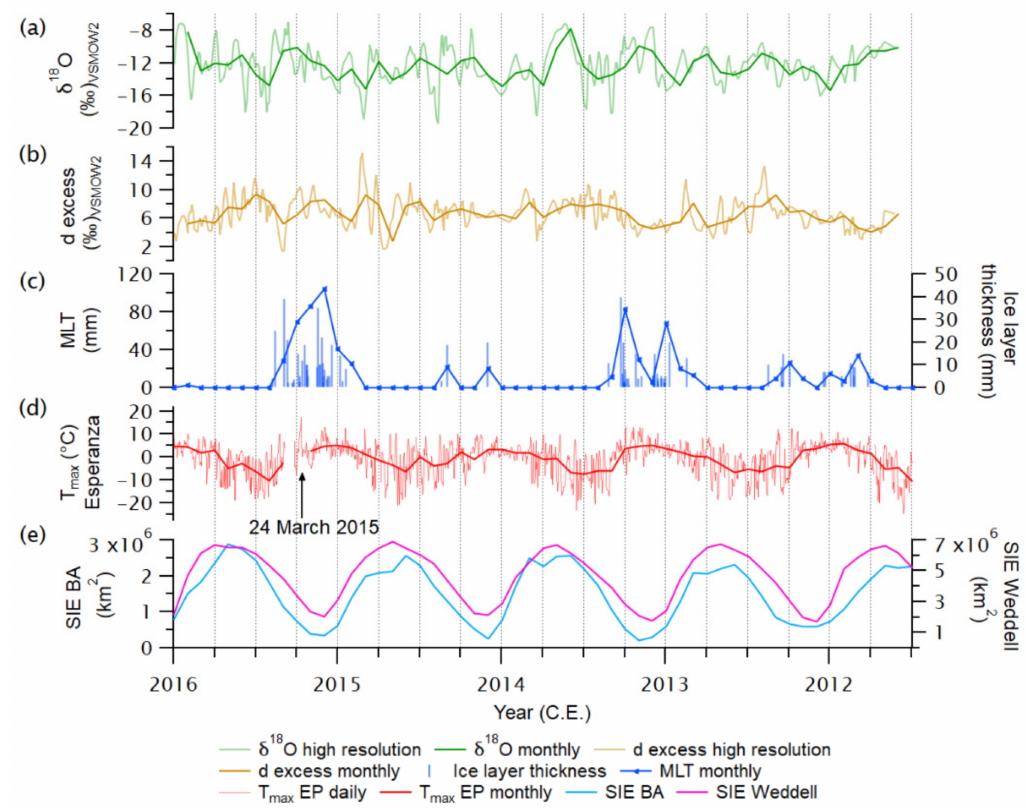
Figure 8. High-resolution (light-coloured lines) and monthly (bold lines) records of OH-12 ( a ) stable oxygen isotopes (green), ( b ) d excess (brown) and ( c ) total melt layer thickness (MLT) calculated from ice layers indicating surface melt (blue) compared to the ( d ) AWS record of daily (light red) and monthly (red) maximum near-surface air temperature from Esperanza station (EP) and ( e ) monthly sea ice extent (SIE) in the Bellingshausen-Amundsen (BA; turquoise) and Weddell Seas (Weddell; pink). Esperanza maximum near-surface air temperatures were obtained from the Global Surface Summary of the Day (GSOD) of the National Centers for Environmental Information (NCEI; available at: https://www.ncei.noaa.gov; last access: 15 June 2021). The day of the record high observed in Esperanza near-surface air temperatures during the atmospheric-river induced warm-air event prevailing in the northern AP region in March 2015 is indicated ( d